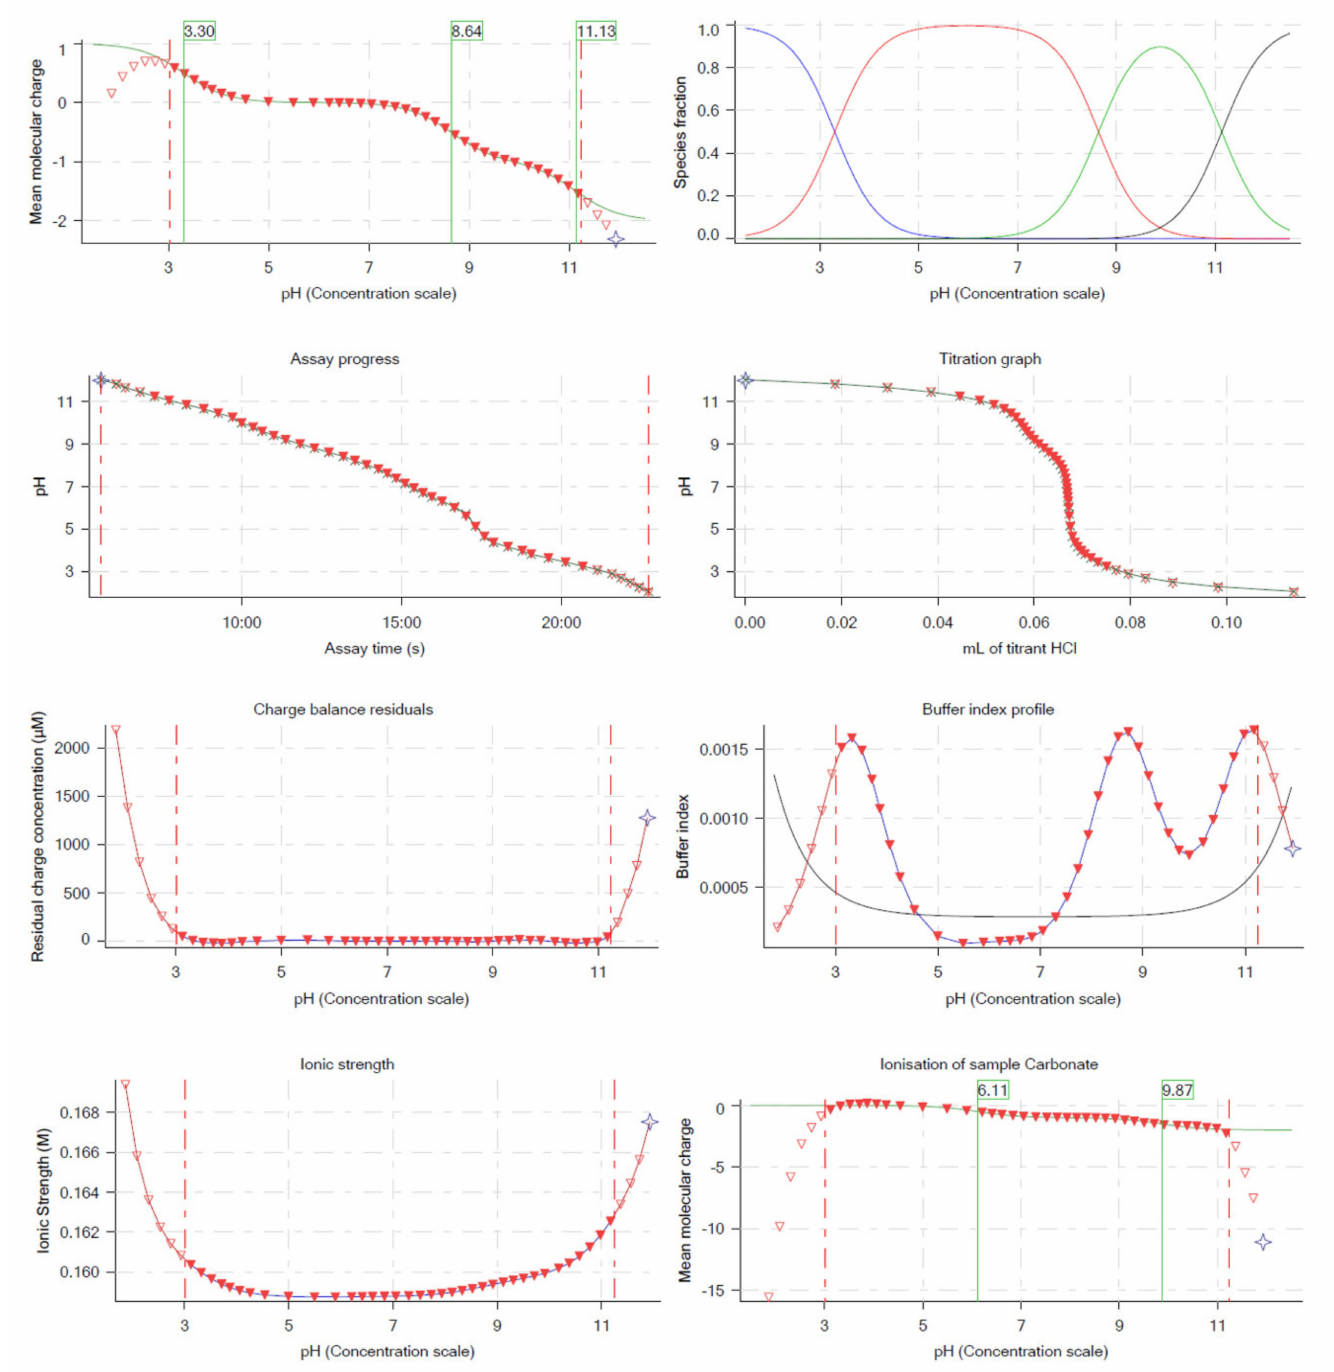
Figure 1. pH − metric pKa measurements of JIN-001 with Sirius